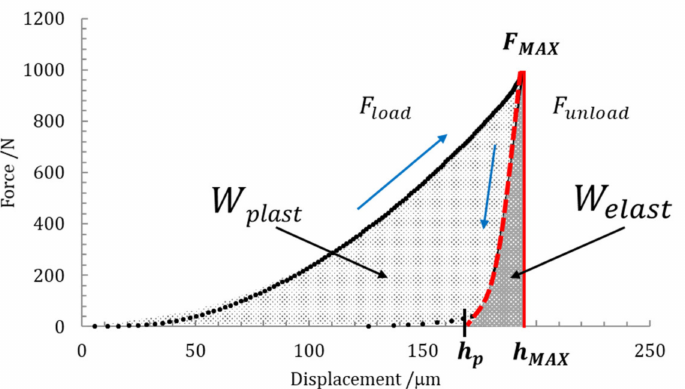
Figure 4. Experimental areas representing the plastic and elastic parts of the indentation work, under the loading and unloading indentation